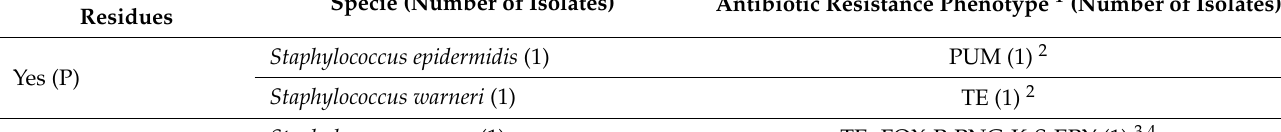
Table 6. Antimicrobial resistance phenotype of staphylococci and Macrococcus caseolyticus isolated from goat meat. Samples with the presence of antibiotic residues (P) and free of antibiotic residues